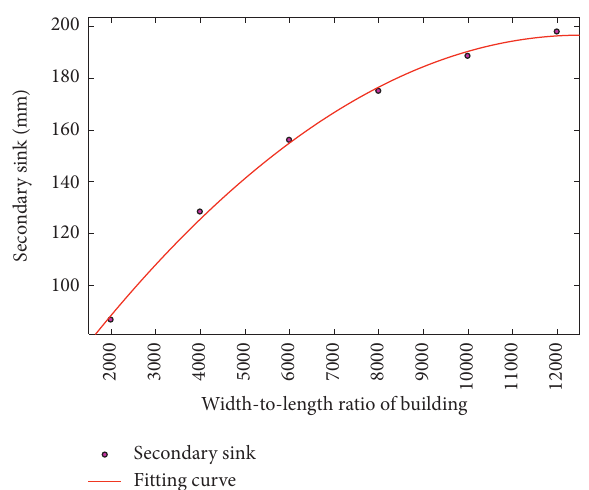
Figure 11: Fitting curve of the building width-to-length ratio and maximum secondary